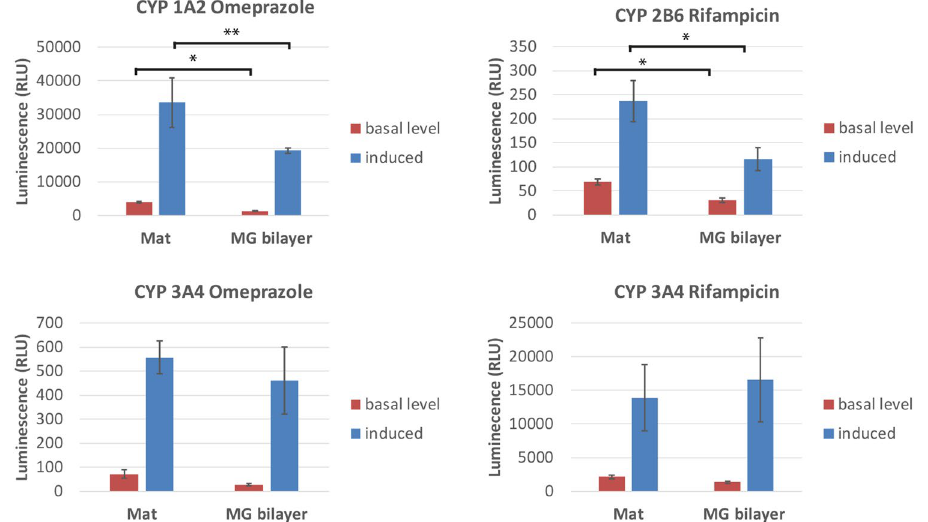
Figure 7. Quantification of CYP 1A2, 2B6 and 3A4 induction by enzymatic activity. CYP1A2 and CYP3A4 were induced by omeprazole, CYP2B6 and CYP3A4 were induced by rifampicin. The human primary hepatocytes were cultured for 20 days and subsequently treated with indicated compounds for 4 days, n = 5. CYP activity was quantified by luminescent method. * indicates a statistically significant (P < 0.05) difference, ** P < 0.01 compared to MG bilayer. RLU relative light units. Primary hepatocytes were cultured in serum-free hepatocyte defined growth